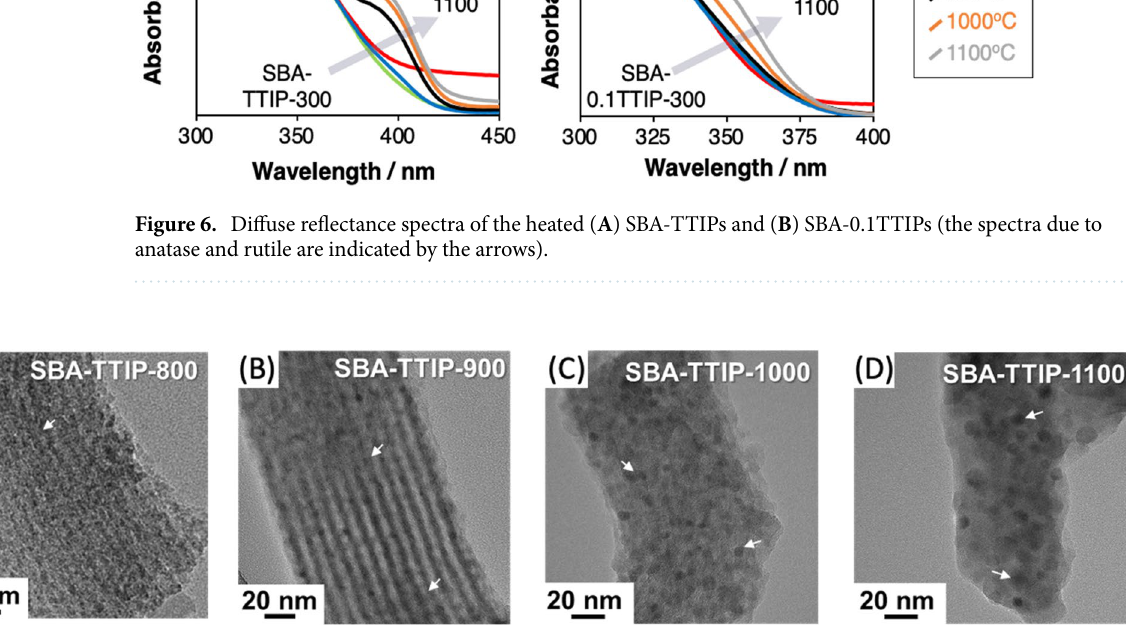
Figure 7. TEM images of SBA-TTIP heated at ( A ) 800, ( B ) 900, ( C ) 1000 and ( D ) 1100 °C (the titania particles are shown by the